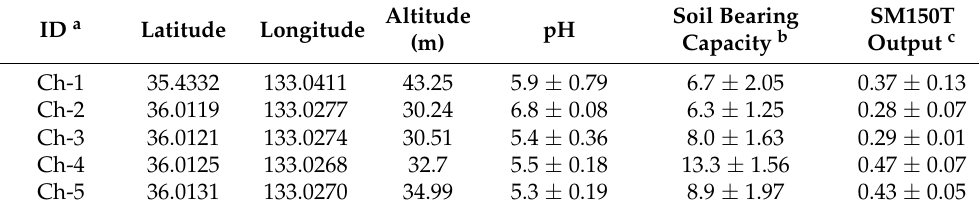
Table 4. Field investigation data recorded from 37 C. cordatum collection